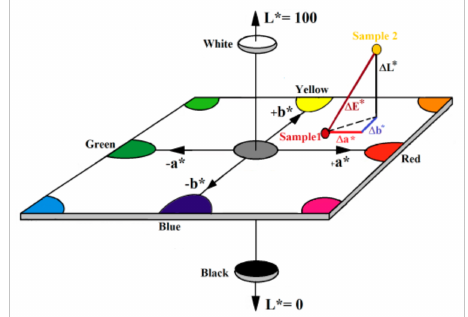
Figure 2. Graphical representation of the CIELab color space based on ref.